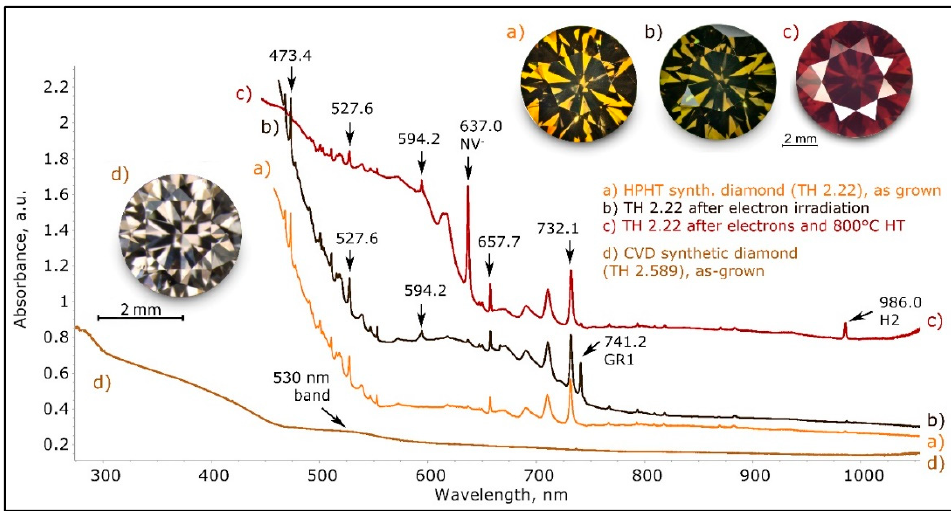
Figure 32. The low temperature UV-Vis-NIR spectra of an olive brown/red brown type Ib > IaA HPHT (High Pressure High Temperature) synthetic diamond (TH 2.22) and a brown CVD (chemical vapor deposition) synthetic diamond (TH 2.589). The olive brown color in the HPHT synthetic diamond is the result from electron irradiation of the originally overly dark yellow stone. The GR1 absorption overlaying the complex spectrum rich in nickel-related absorptions results in the basically brown color (trace b ). Heating this stone at 800 °C for 2 h resulted in the deep red brown color, from the newly formed intense NV - center absorption (trace c ). Trace ( d ) shows the spectrum of an as-grown brown CVD synthetic diamond; the brown color is caused by a featureless continuum, just like many type IIa natural brown diamonds; the only overlaying absorptions visible are a weak broad band at 530 nm and a series of very weak sharp peaks (not indexed). While HPHT synthetic diamonds must be treated to appear brown, CVD synthetic diamonds are often grown brown and need HPHT treatment to decolorize them. The spectra have been shifted vertically for clarity.